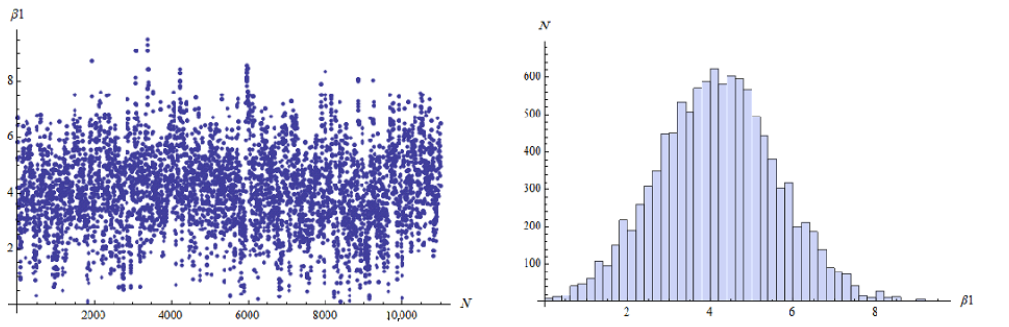
Figure 5. Trace ( Left ) and histogram ( Right ) plots of the parameter θ 22 .